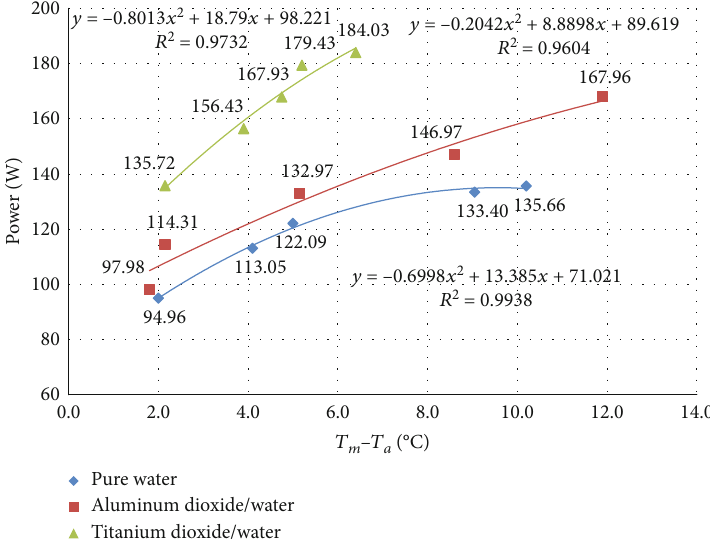
Figure 12: Power output per momentary temperature di ff erence for pure water, Al